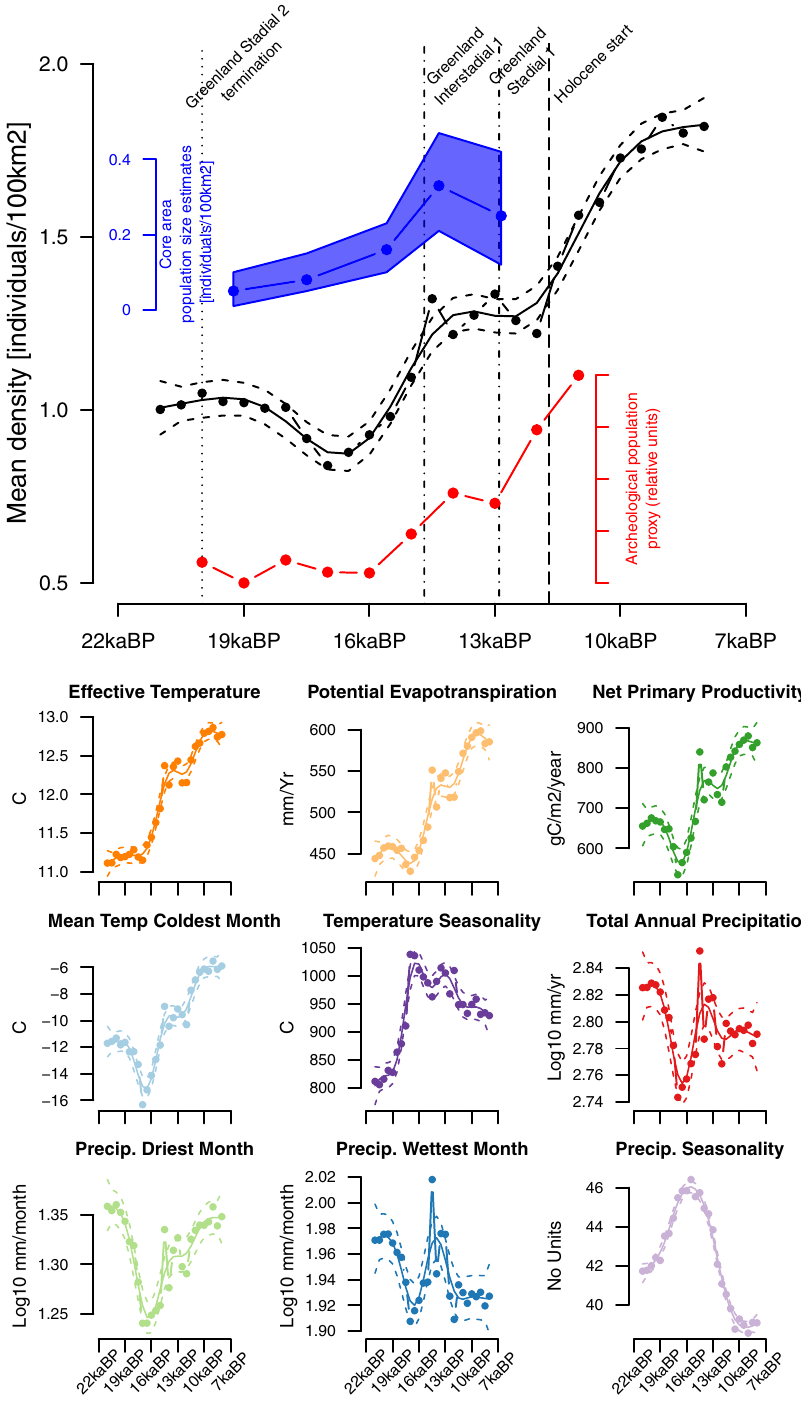
Fig. 3 | Estimates of climatically possible mean population density (top) and trends in key environmental variables (bottom). Estimated average population densityforallofEuropeisbasedontheaverageof grid-basedpopulationdensities (minimum predicted density for a cell) in ice-free regions (black line — top panel) basedonthe50thpercentilegeneralisedadditivemodels(qGAM).Heresolidblack linesshowthemeanpredictedvaluesand blackdashed bandsindicateeachmodel prediction ’ s 95% con fi dence intervals. Estimates for 90th and 10th quantiles are presentedinSupplementaryFig.1.Theseestimatesarecomparedtoarchaeological populationproxybased on thenumberofcalibratedradiocarbondatesforEurope